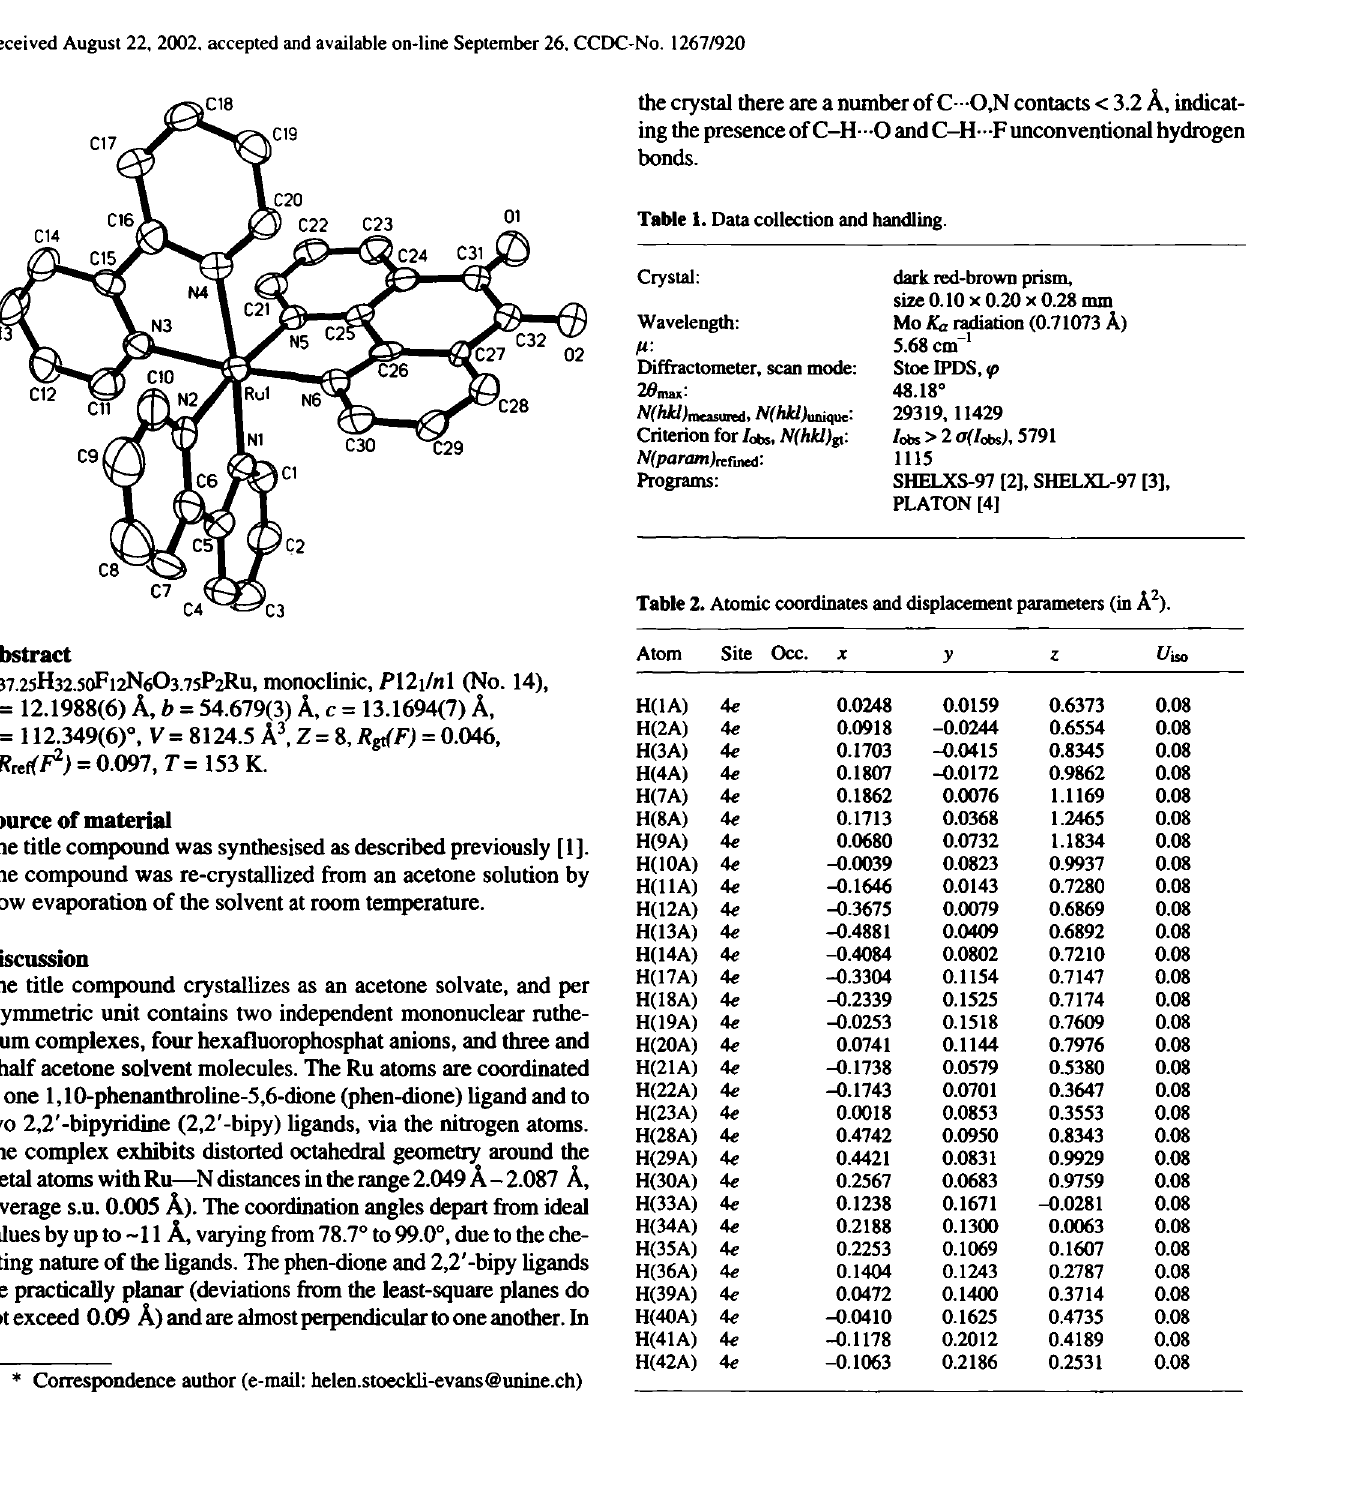
Table 1. Data collection and handling.